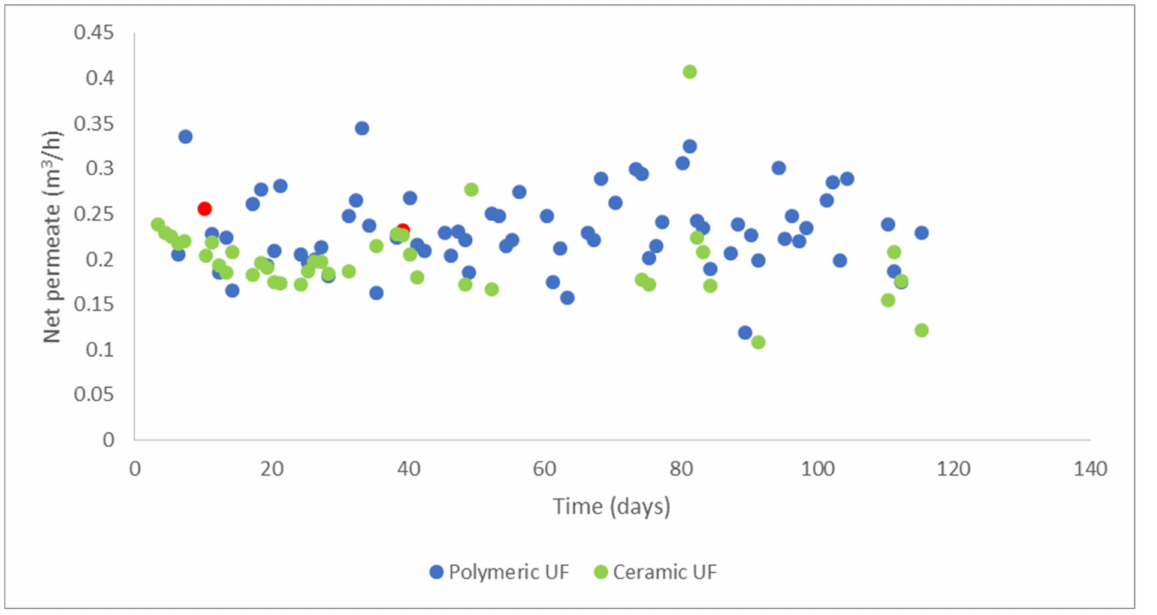
Figure 2. Net permeate flow of the Polymeric UF and the Ceramic UF. The red dots indicate the membrane changeovers on the polymeric UF line.